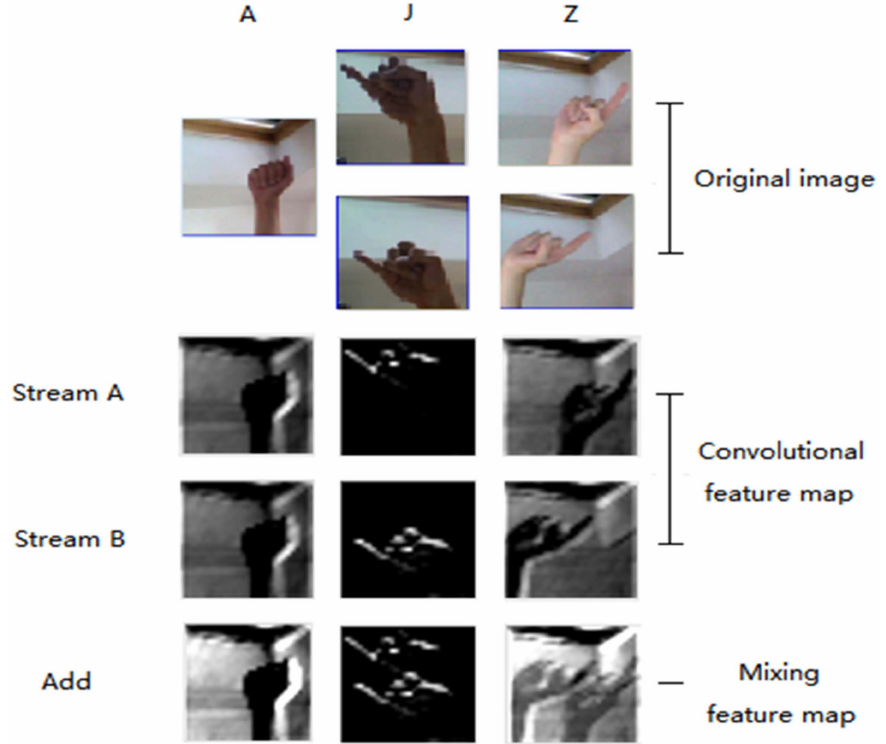
Figure 7. Different Feature